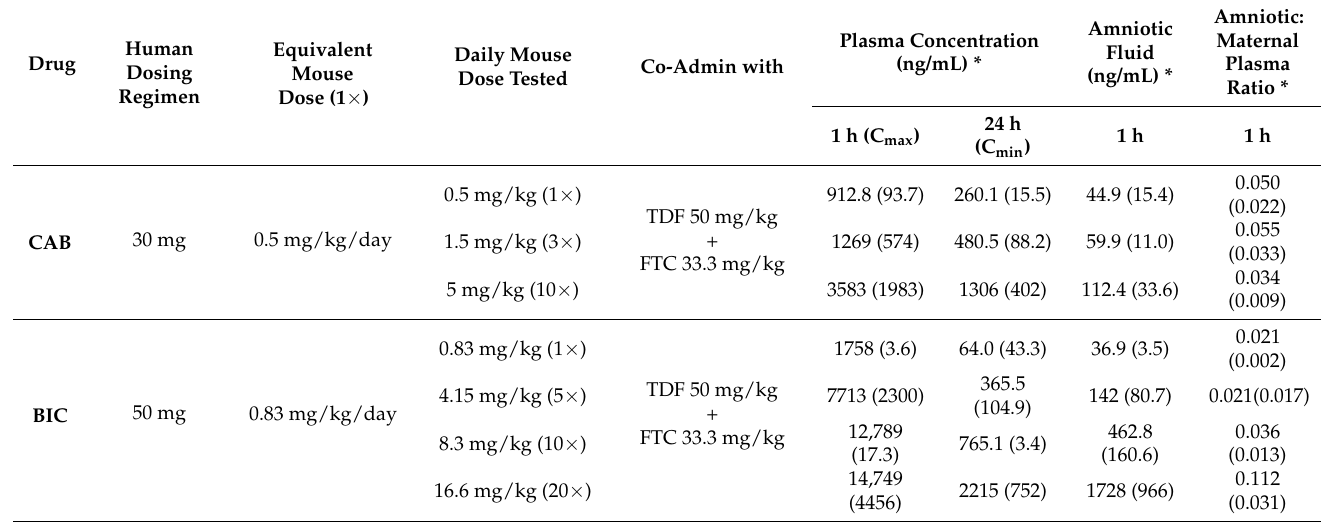
Table 1. Pharmacokinetic dosing evaluation of cabotegravir and bictegravir in a mouse